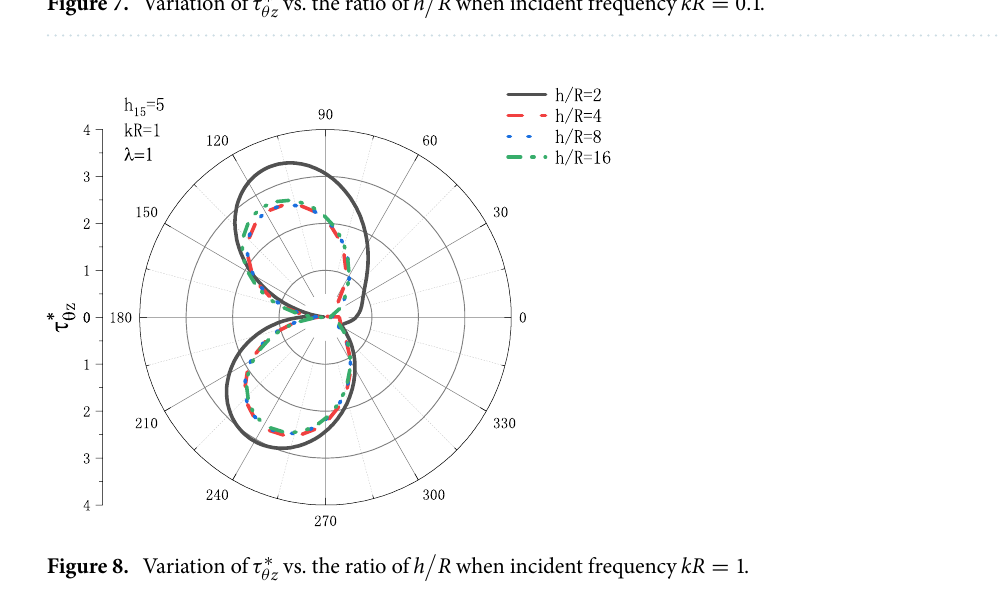
Figure 7. Variation of τ ∗ θ z vs. the ratio of h